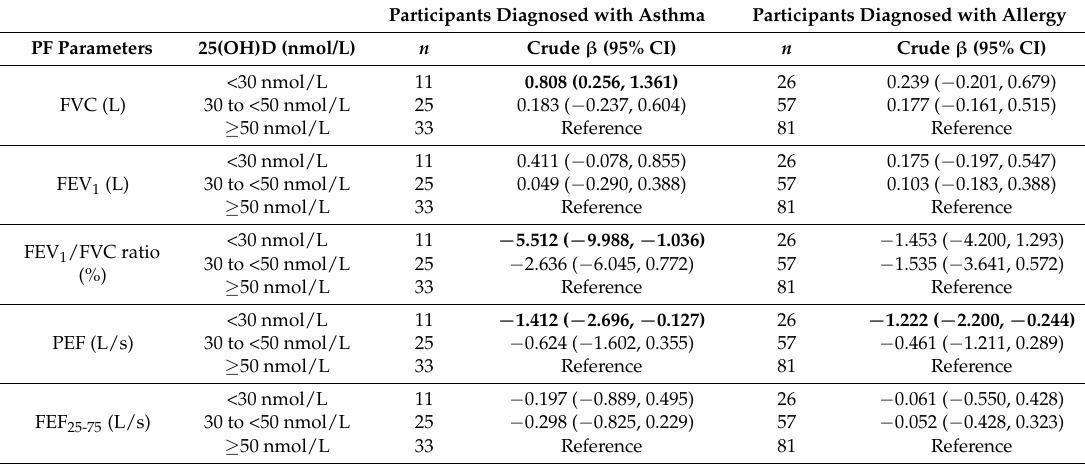
Table 7. Association of serum 25(OH)D categories with pulmonary function (PF) parameters in participants diagnosed with asthma and in participants diagnosed with allergy. Participants Diagnosed with Asthma Participants Diagnosed with